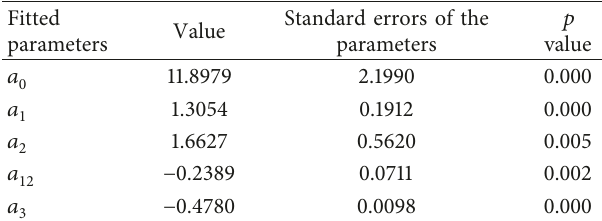
Table 4: Linear regression parameters.